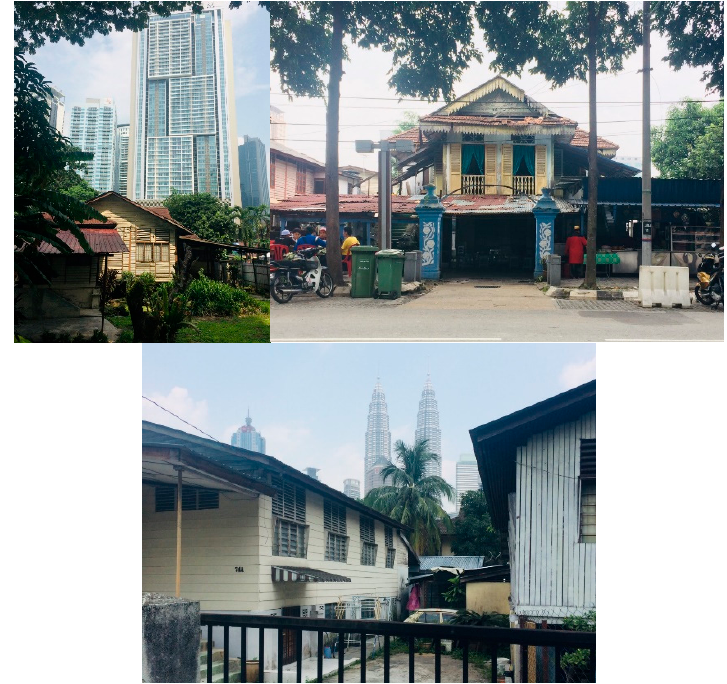
Figure 3. Some examples from the traditional Malay building stock in Kampung Baru (photos taken by Y. D. Aktas in 2016).